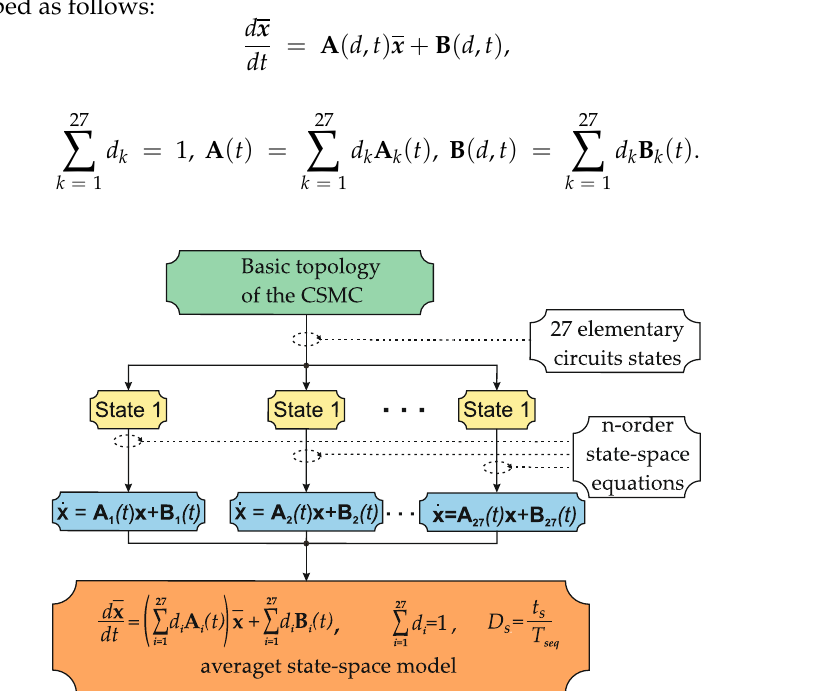
Figure 6. Block diagram for describing the method of averaging state variables for CSMC.